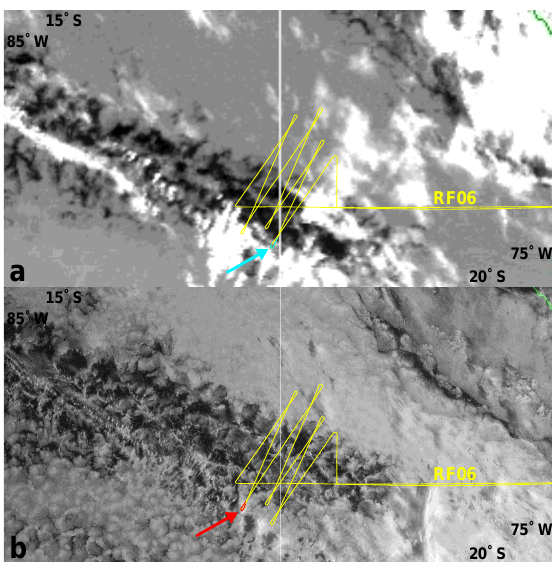
Fig. 8. GOES-10 imagery on 28 October 2008 in thermal infrared at 08:45 UT (a) with 4km resolution, and in visible at 11:45 UT (b) with 1km resolution, and the VOCALS-REx RF06 flight route (yel- low). Locations of POC profiles taken at 09:05UT and 11:36UT are marked in cyan and red, respectively. The satellite images cover the Southeast Pacific from 75–85 ◦ W, and from 15–20 ◦